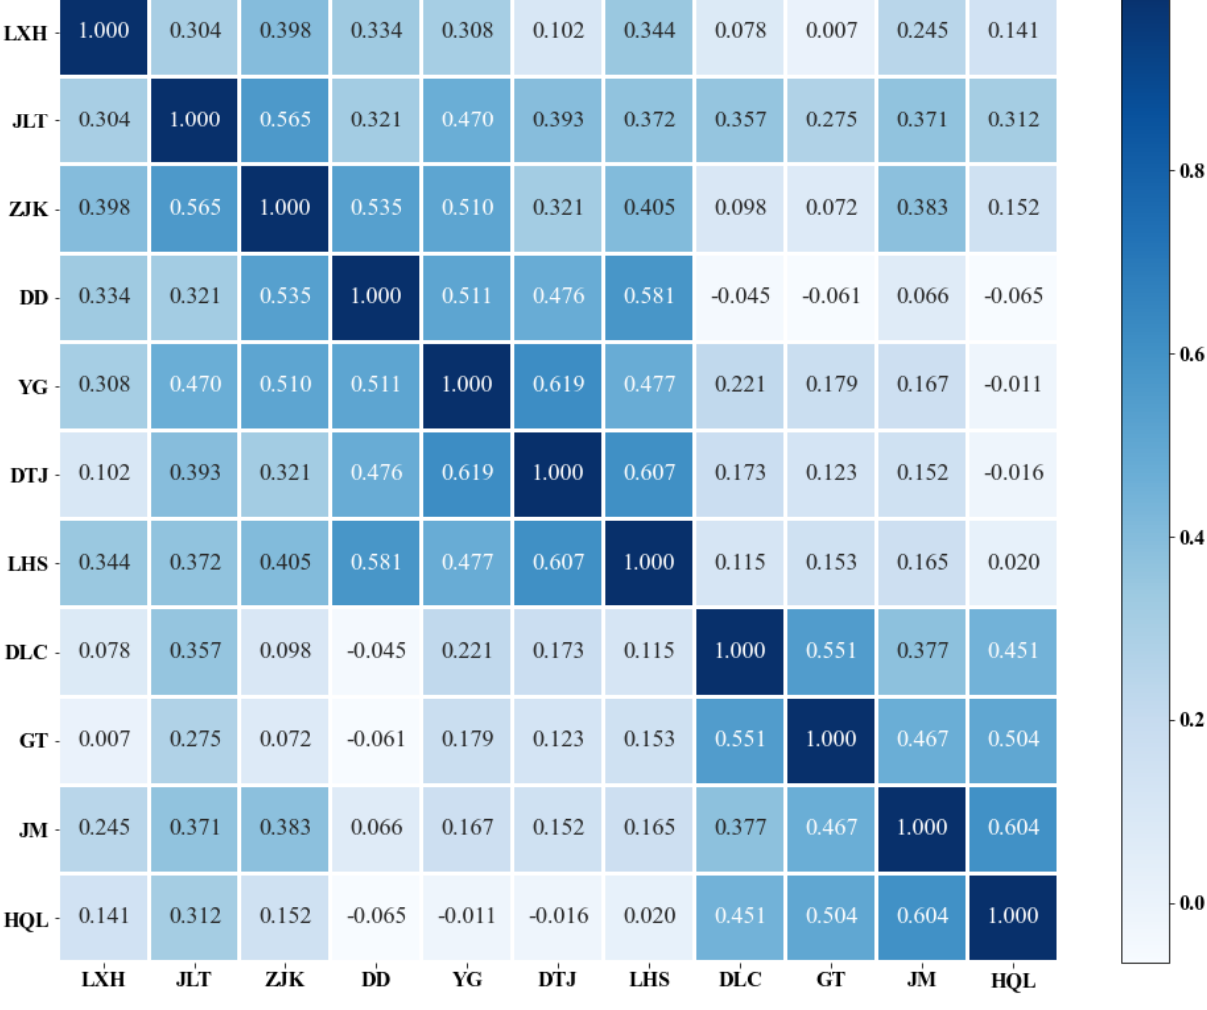
Figure 5. Pearson’s correlation coefficient of WQI among the monitoring stations.